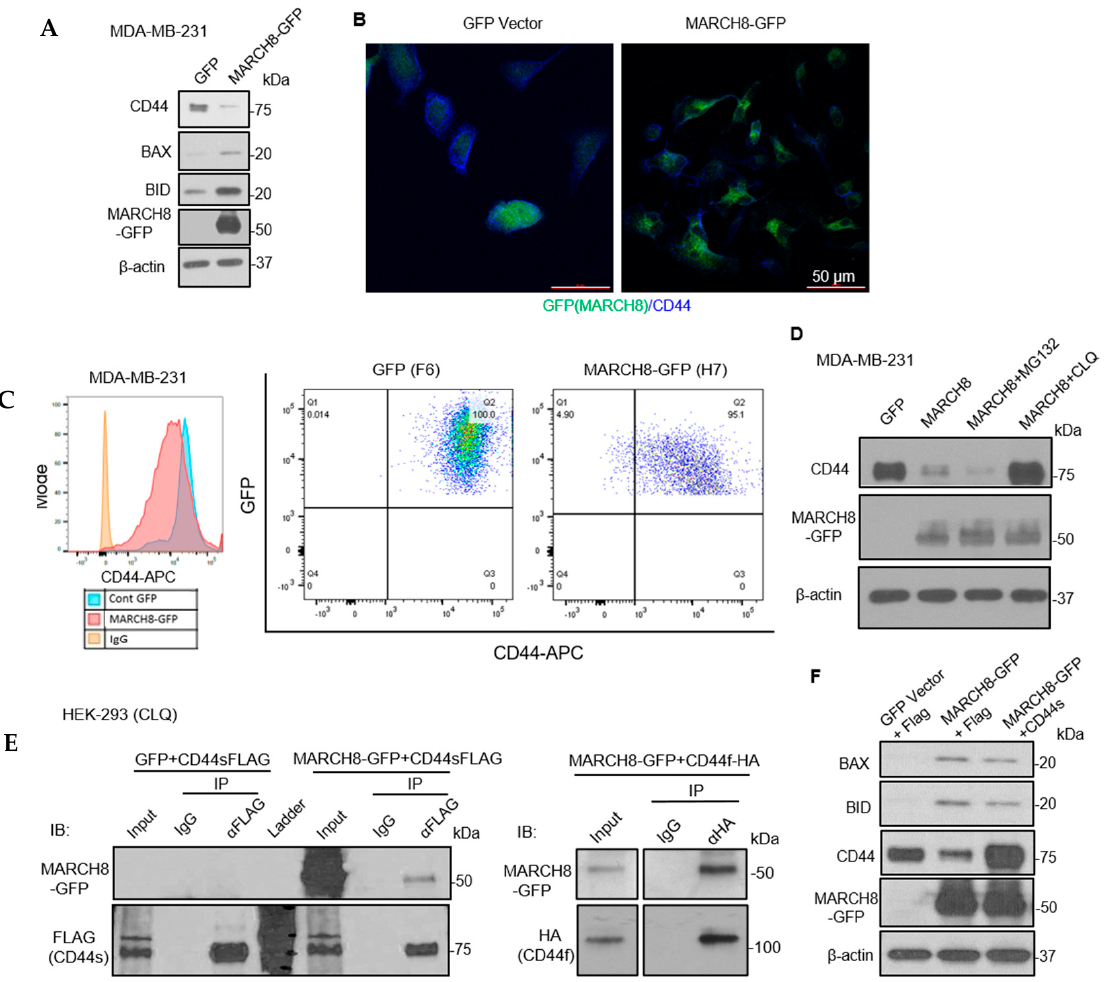
Figure 5. MARCH8 interacts with and degrades CD44 through the lysosome pathway. ( A ) Immunoblots to detect decreased CD44 and increased BAX, BID, and MARCH8 expression levels in MARCH8-overexpressing cells compared to GFP control cells. ( B ) Immunofluorescence staining with anti-CD44 antibody showing decreased expression of membrane protein CD44 (blue) in MARCH8-GFP expressing cells. ( C ) Flow cytometry histogram overlay (left panel) and dot plots (right panels) indicating MARCH8-decreased CD44 expression levels in negative association with MARCH8-GFP signals. ( D ) Immunoblots of endogenous CD44 and exogenous MARCH8-GFP after transient transfection of MARCH-GFP and treatment with MG-132 or chloroquine (CLQ) to block the proteasomal or lysosomal degradation pathways, respectively. ( E ) Immunoblots of MARCH8 and FLAG-tagged CD44 after anti-FLAG mediated immunoprecipitation (IP) of the lysates of HEK-293 cells after transfections with MARCH8-GFP and CD44-FLAG (standard isoform CD44s and full-length CD44f) and treatment with CLQ, indicating the interactions between MARCH8 and CD44 (CD44s or CD44f). ( F ) Immunoblots of BAX, BID, CD44, and MARCH8 in the MDA-MB-231 cells with stable expression of GFP or MARCH8-GFP with transient transfection of a FLAG vector control or restoration of CD44 expression via CD44s-FLAG. CD44 overexpression slightly inhibited the expression of proapoptotic BID and BAX in MARCH8-GFP-overexpressing cells.